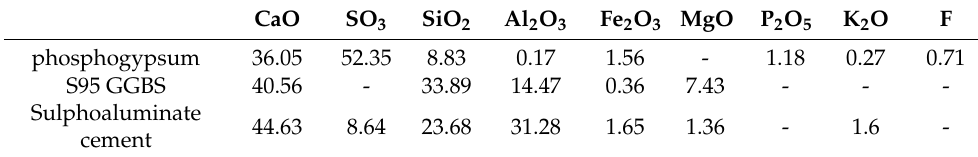
Table 1. Raw material composition